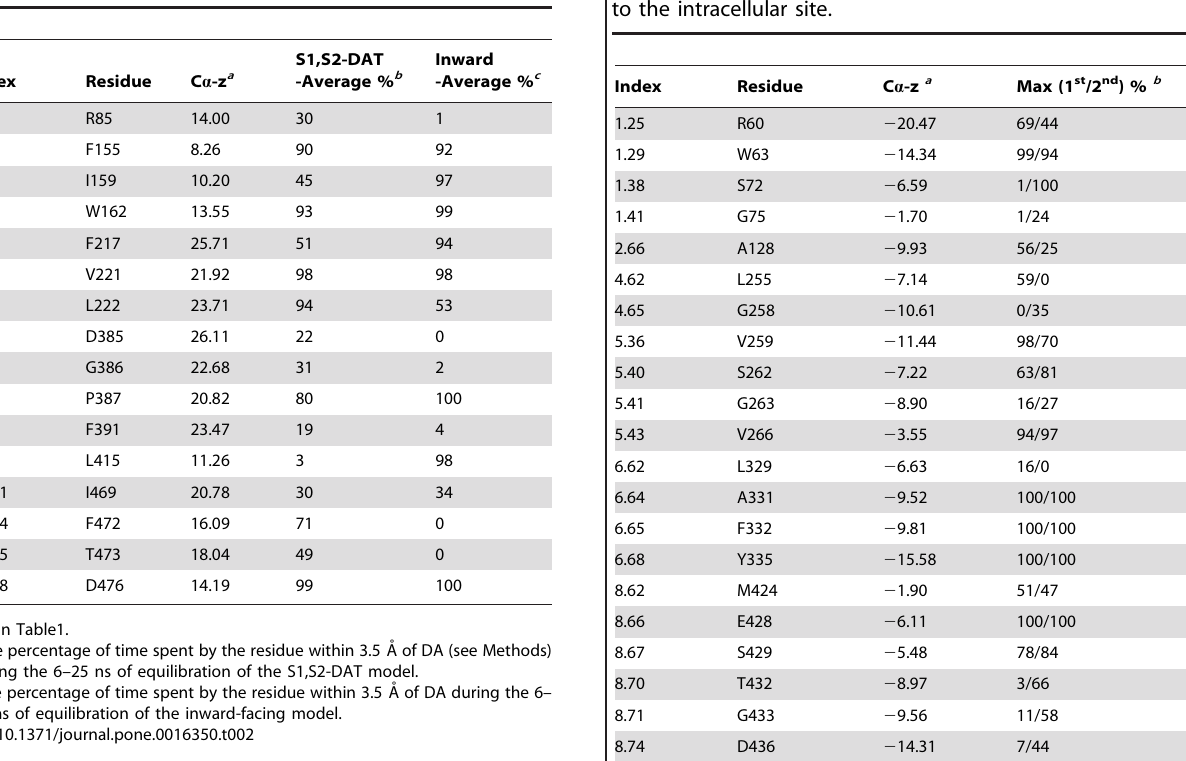
Table 2. Composition of the S2 site.